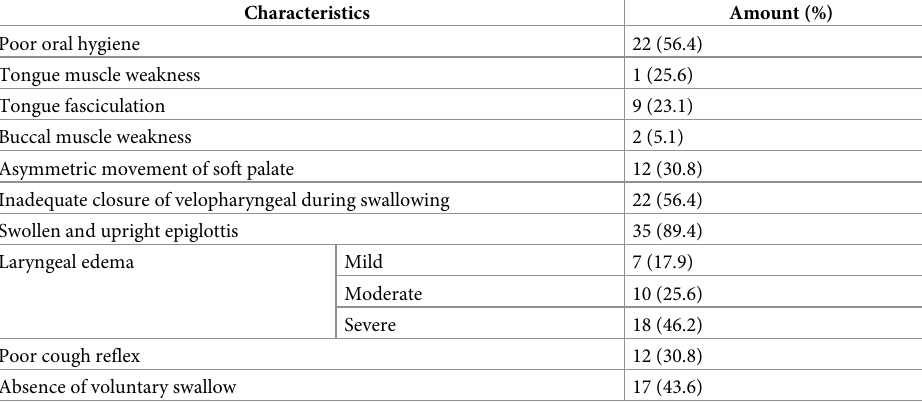
Table 2. The results of the initial assessment with FEES (n =